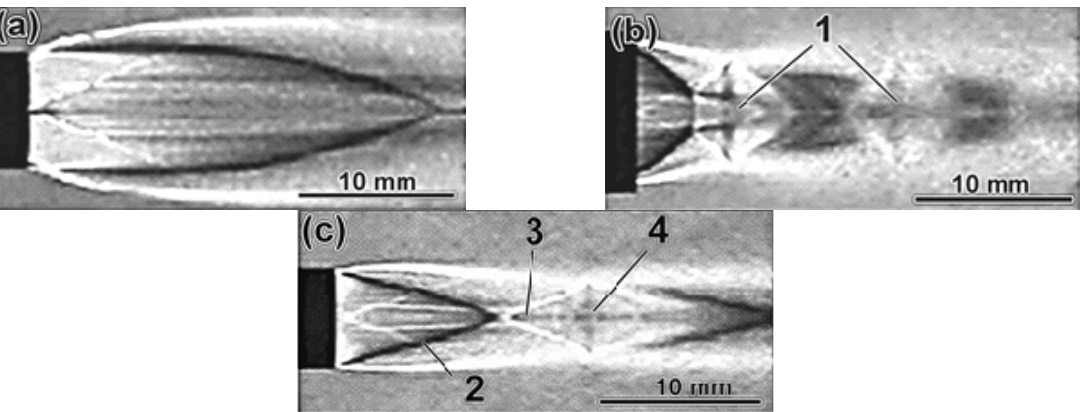
Figure 6. Gas spectrograms of the airflows: ( a ) without pulsation, ( b ) with pulsation frequency 75 Hz for conical nozzle, ( c ) with pulsation frequency 75 Hz for cylindrical nozzle. 1—Mach disc; 2—the zone of the initial gas-dynamic spike; 3—the transitional zone; 4—the main zone (the front of Mach disc).